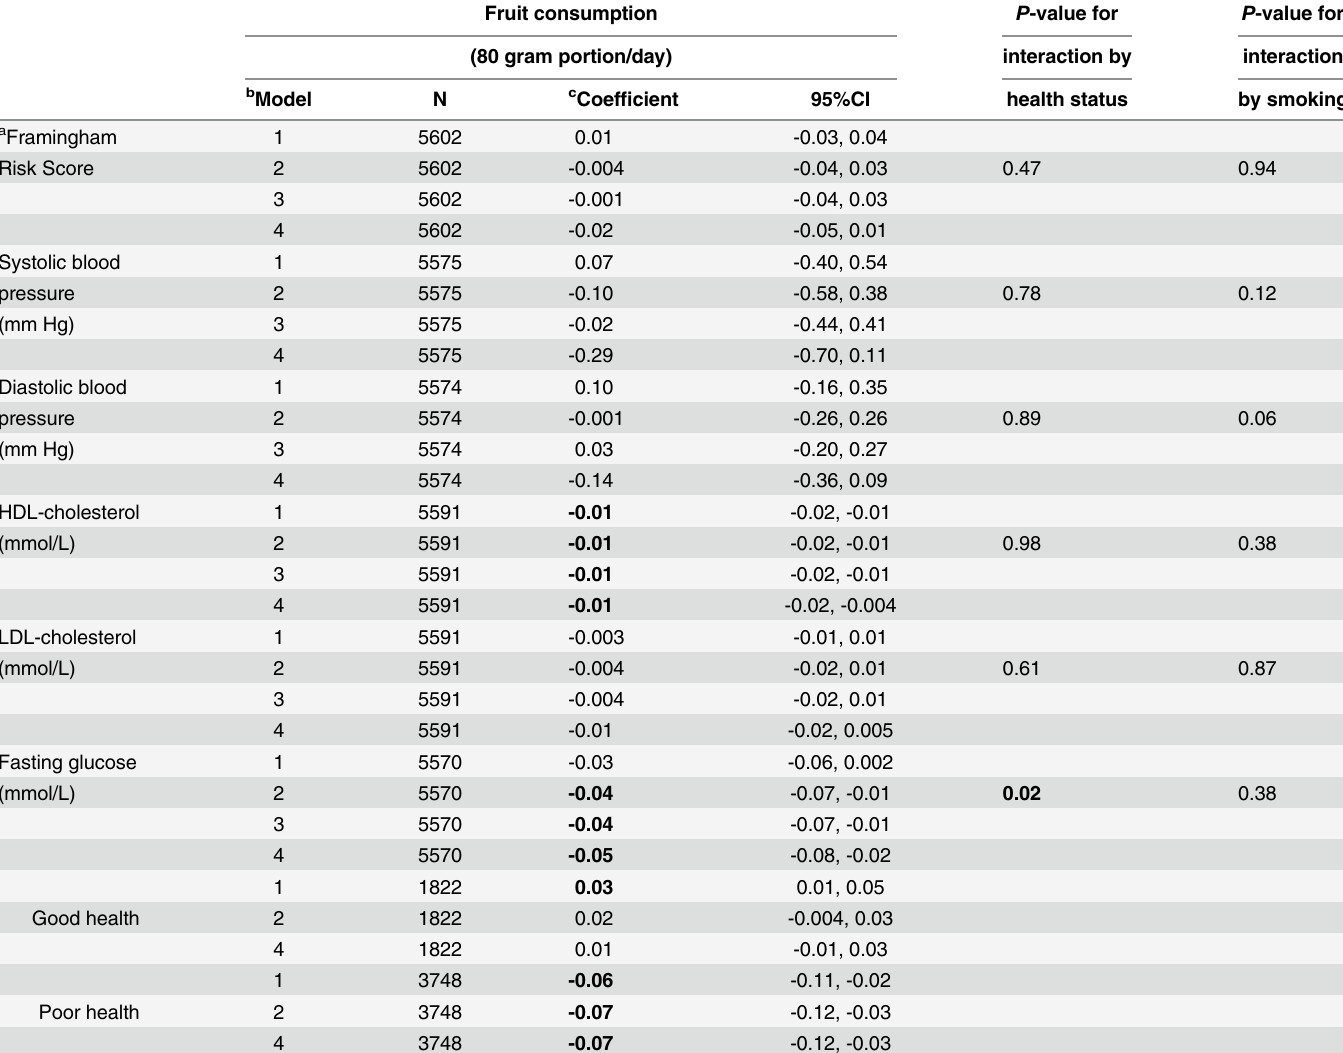
Table 4. Adjusted Associations of Fruit Consumption with Framingham Risk Score and CVD Risk Factors after Multiple Imputation in Older Chi- nese Men in Phases 1 and 2 of the Guangzhou Biobank Cohort Study, 2003 – 2006. Fruit consumption P -value for P -value